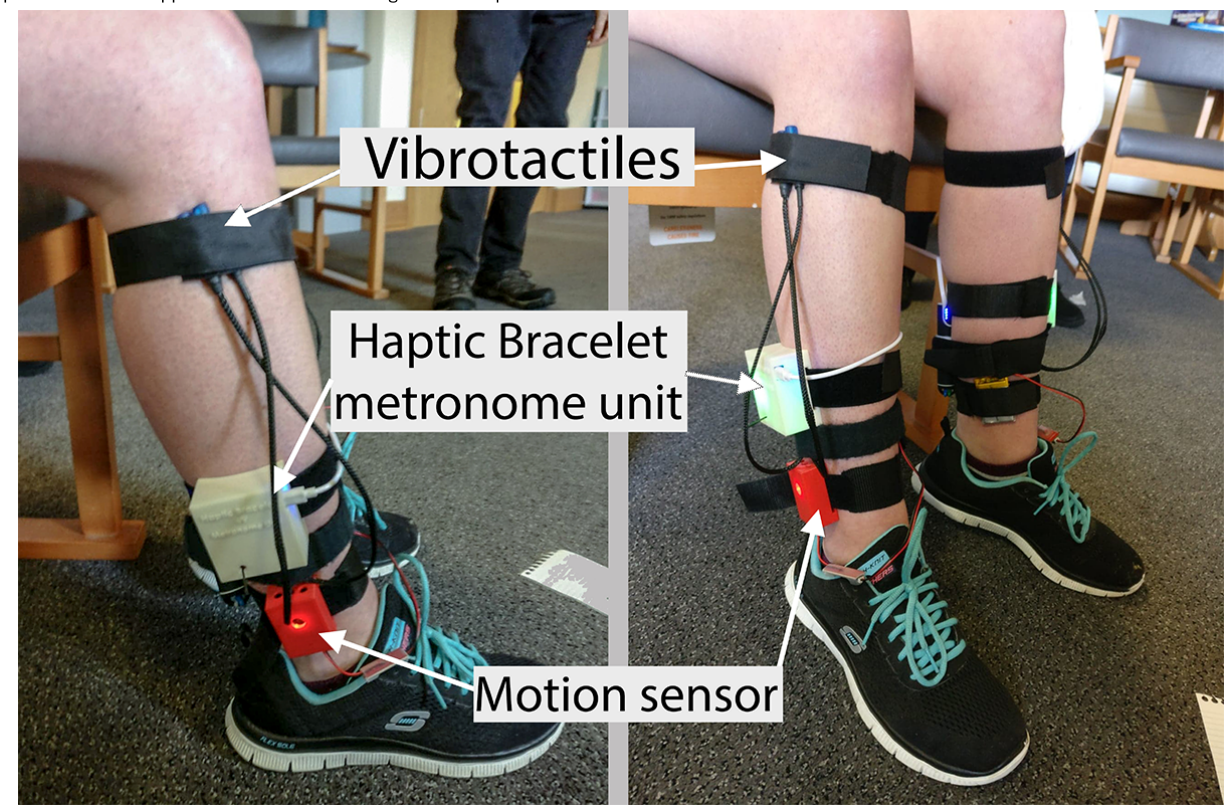
Figure 2. The Haptic Bracelet wearable devices placed on the participant’s legs (one device on each leg). The vibrotactiles used for delivering the haptic cues were strapped on near the knee using Velcro